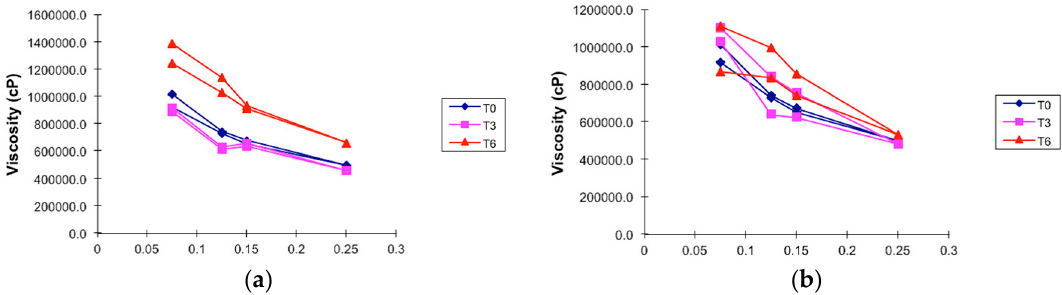
Figure 7. Viscosity—share rate curves of hydrogel-based formulation of ethanolic extract of P. granatum (2%, w / w ); T0: after production, T3: 3 months and T6: 6 months of storage at different storage conditions. ( a ) Climatic chamber; ( b ) Temperature test chamber. Results are represented by means ( n = 3).